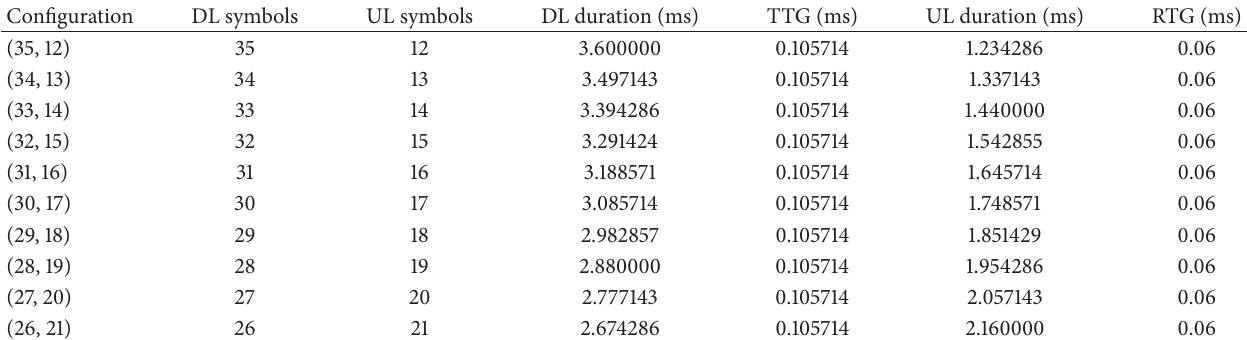
Table 3: WiMax frame configuration (TDD mode,